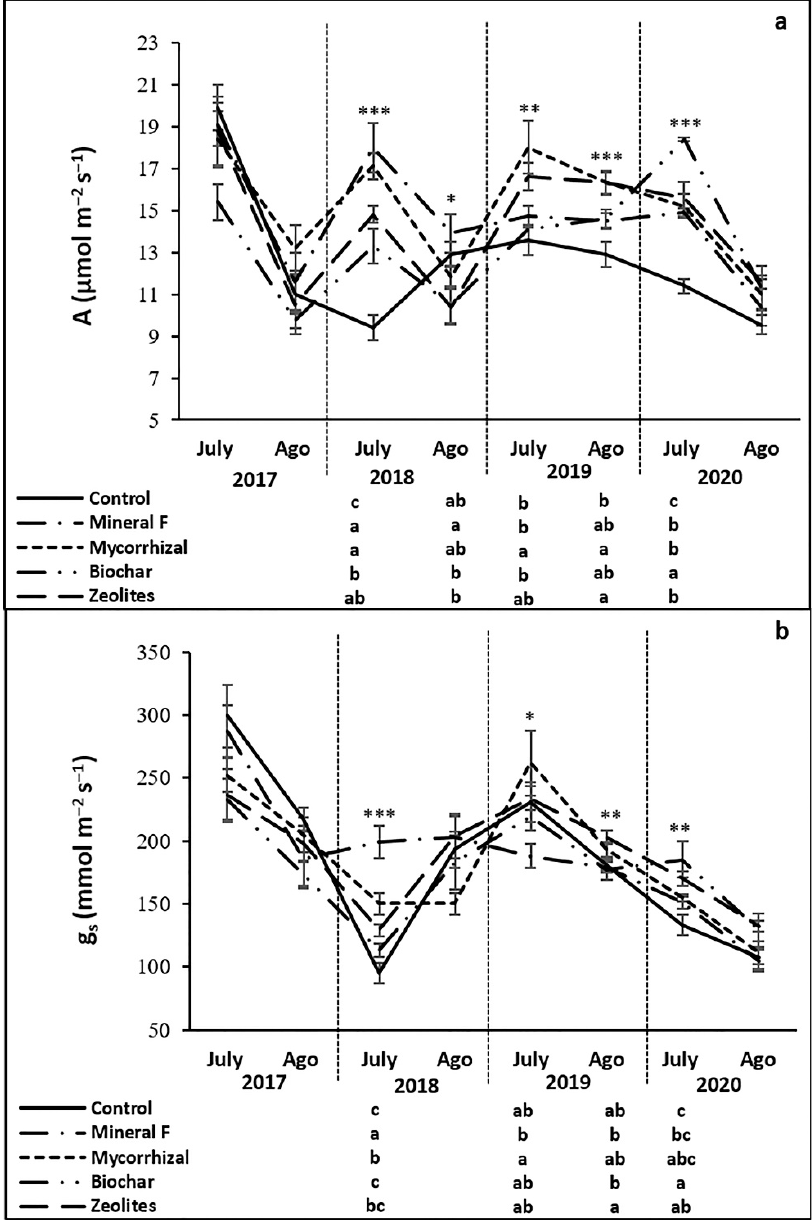
Figure 4. Evolution of net photosynthetic rate ( a ) and stomatal conductance ( b ) throughout the experiment. Different letters demonstrate significant differences by Tukey HSD test ( p < 0.05) between treatments in each date. Vertical bars are the standard errors; * ( p < 0.05), ** ( p < 0.01) and *** ( p < 0.001) are the results of analysis of